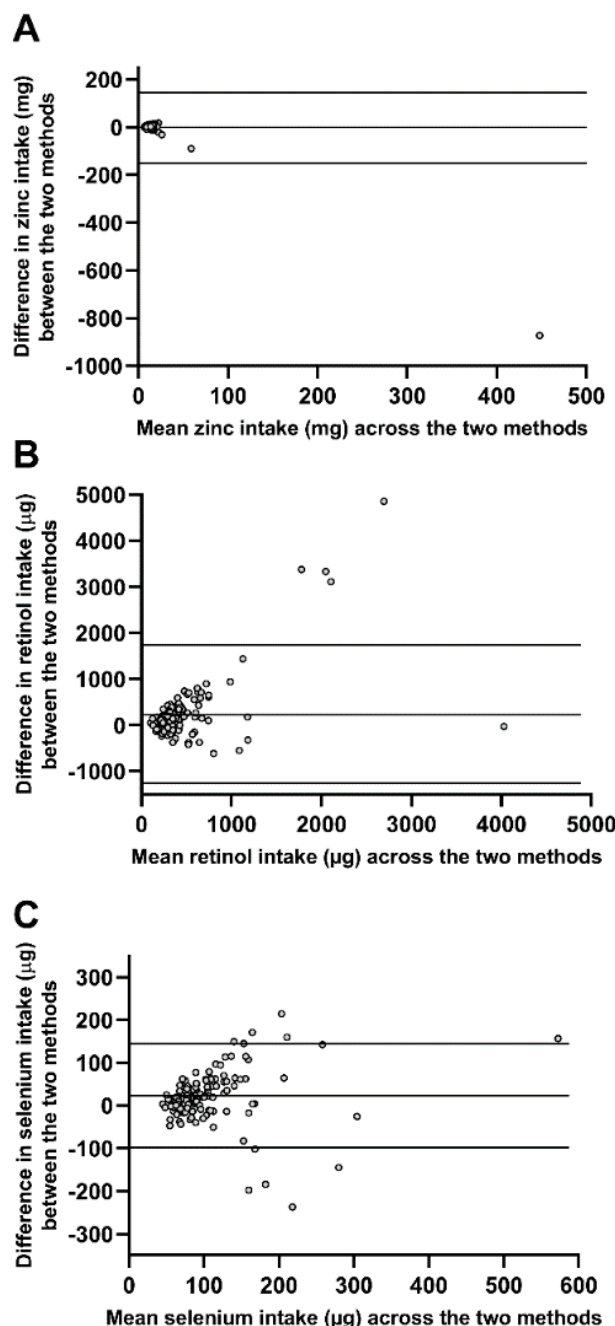
Figure 2. Bland–Altman plots depicting examples of “good agreement” ( A ), “fairly good agreement” ( B ), and “poor agreement” ( C ) of nutrient intakes determined using the AD-CSIROFFQ and four-day weighed food records. The di ff erence in intake of nutrients between the two methods is plotted against the mean intake across the two methods for each individual. Upper horizontal line shows one standard deviation above the mean intake, middle horizontal line is the mean intake, and lower horizontal line shows one standard deviation below the mean intake. Abbreviations: AD-CSIROFFQ, Alzheimer’s disease-Commonwealth Scientific and Industrial Research Organisation Food Frequency